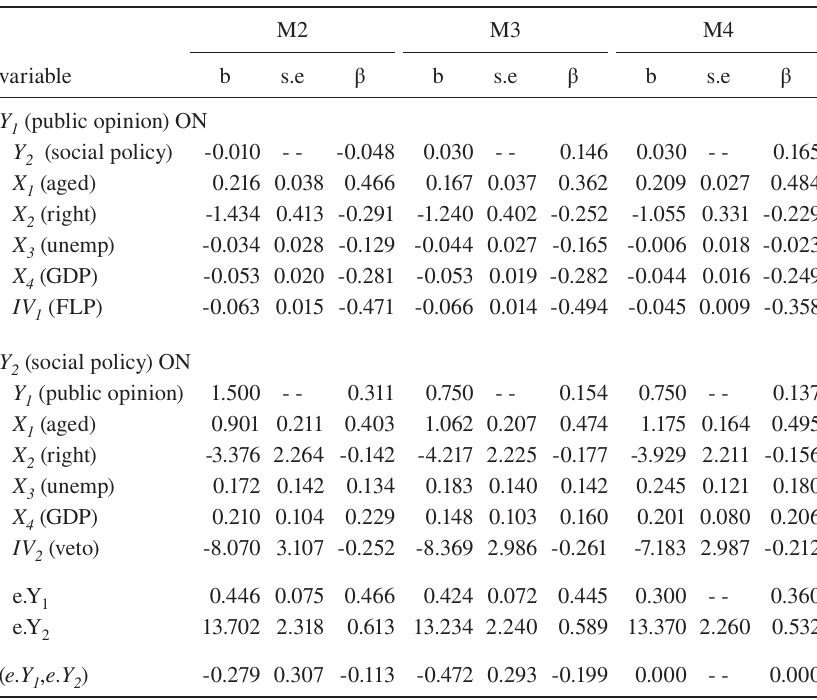
Models of Competing Theories of Opinion-Policy